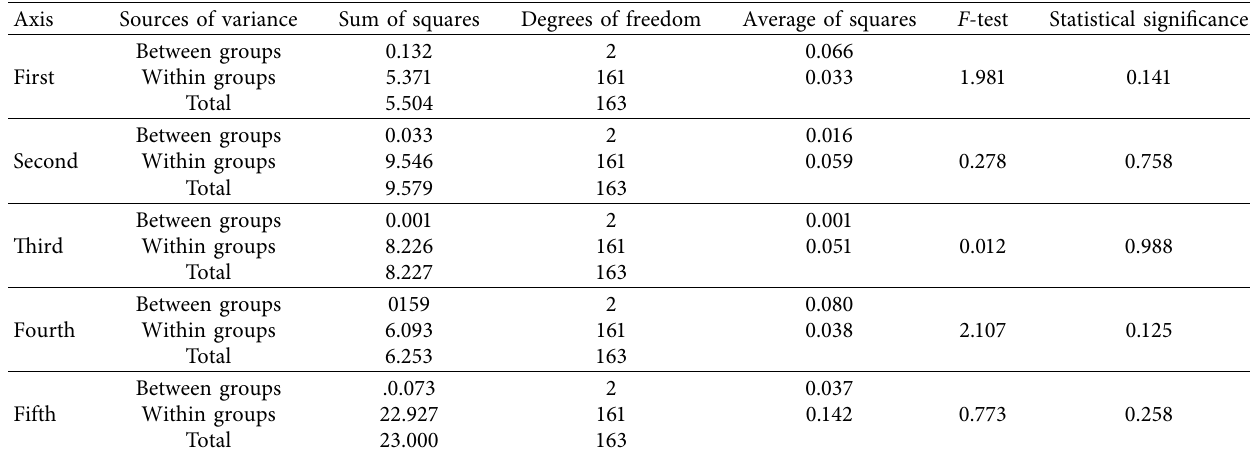
Table 13: Results of the F -test for a comparison between the averages of responses to the questionnaire on the use of MTM by faculty members at the UOH according to the variable of the academic specialization.